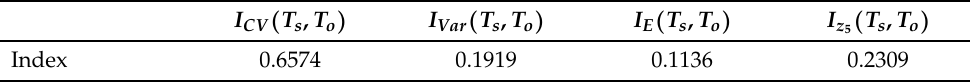
Table 5. Computed indices from the observed and true first-passage time